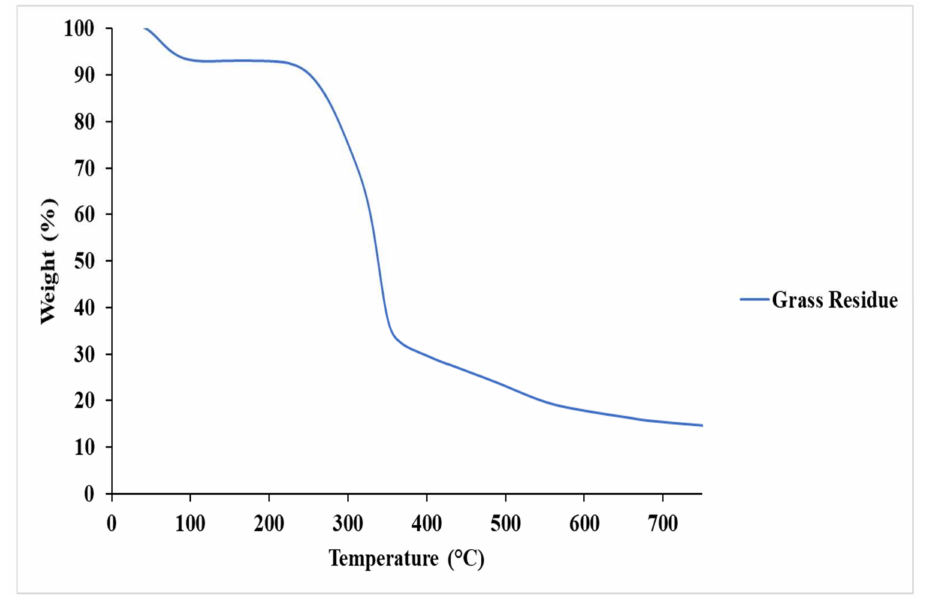
Figure 2. Volatility of grass